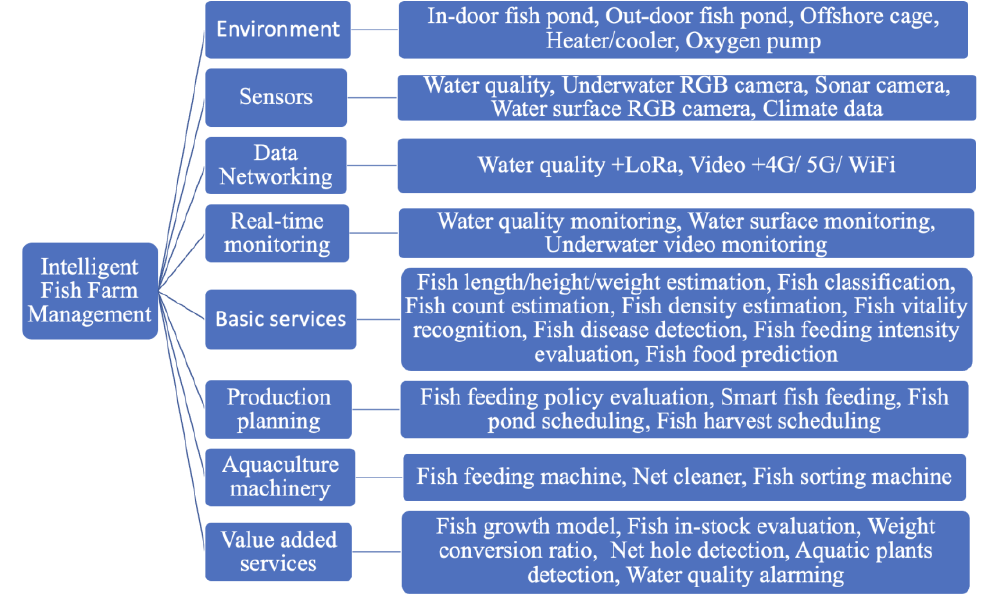
Figure 5. Hierarchy of digital twin architecture related to the AIoT system for intelligent fish farm management. farm